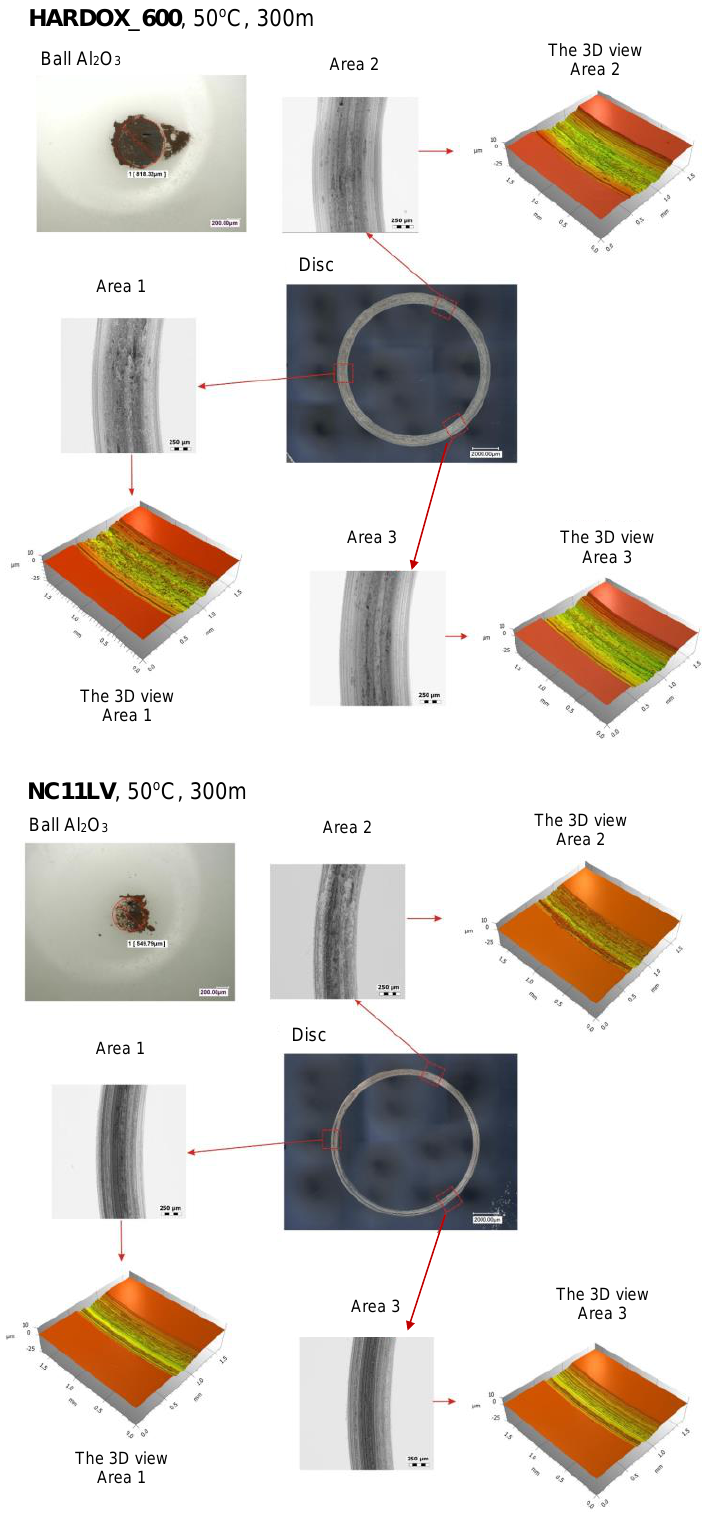
Figure 7. Results of ball-on-disc tests for the analyzed materials.